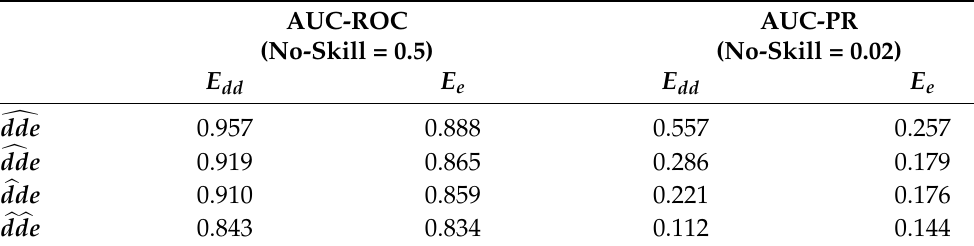
Table 1. Final test performances with pooling aggregation. These represent the averages of the distributions shown in Figure 4. They are obtained as illustrated in Figure 3 for both evaluation schemes. The test predictions of the ten folds were pooled together into one final evaluation such that each of the distributions is unambiguously determined. No-skill performance for AUC-ROC and AUC-PR is 0.5 and 0.02, respectively. Details on the computation and the no-skill value of AUC-PR can be found in Appendix D. Both metrics have perfect-skill performance at 1. AUC-ROC AUC-PR (No-Skill =